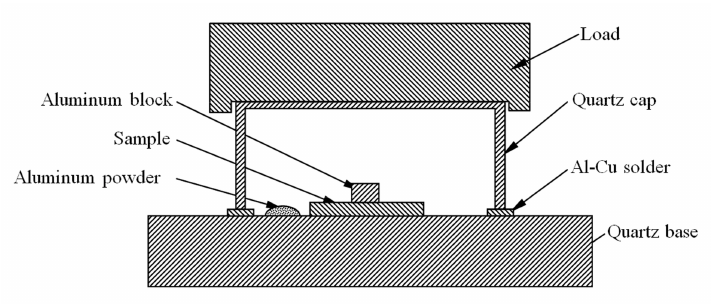
Figure 2. The schematic of the sealed